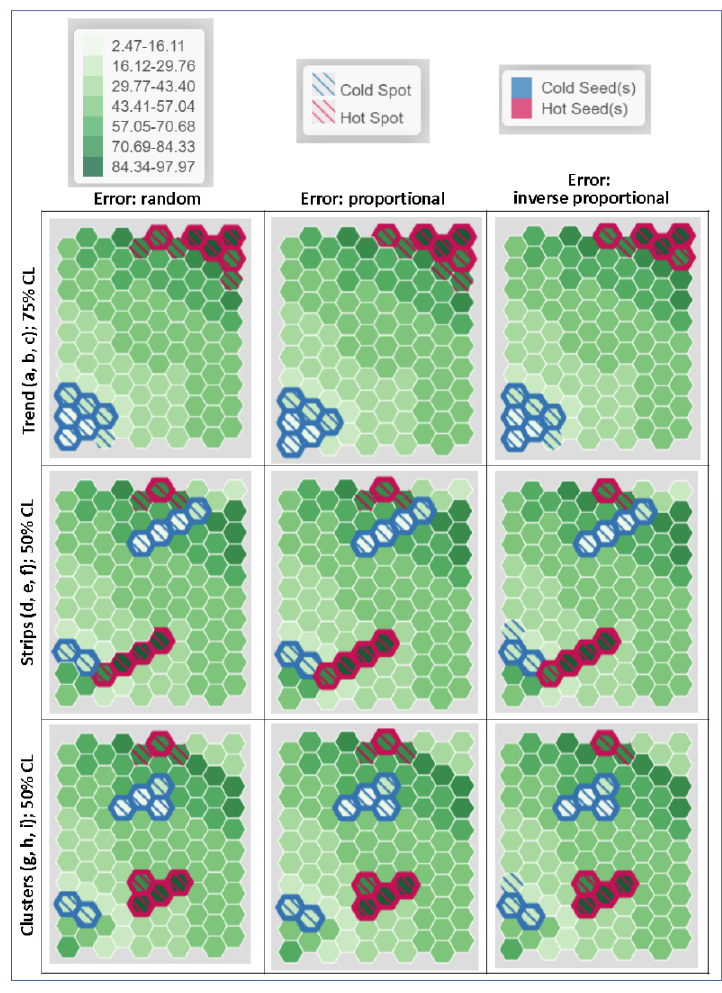
Figure 7. Heuristic detection results for the nine 100-hexagontal configurations. Trend patterns with random error ( a ), error proportional to estimates ( b ), and error inversely proportional to estimates ( c ); two-strip patterns with random error ( d ), error proportional to estimates ( e ), and error inversely proportional to estimates ( f ); two compact-cluster patterns with random error ( g ), error proportional to estimates ( h ), and error inversely proportional to estimates ( i